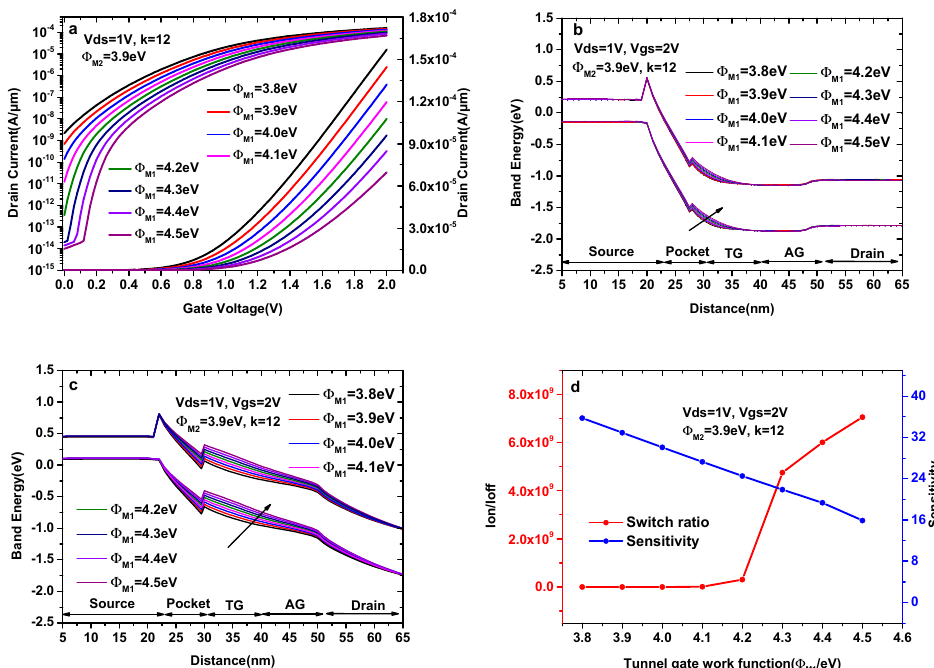
Figure 5. ( a ) Transfer characteristics of DMG-HJLTFET; ( b ) the variation of the ON-state energy band diagram; ( c ) the variation of the OFF-state energy band diagram; and ( d ) sensitivity and switch ratios (k = 12) with different tunnel gate work functions ( Φ M1 ). (k = 12) with different tunnel gate work functions ( Φ M1